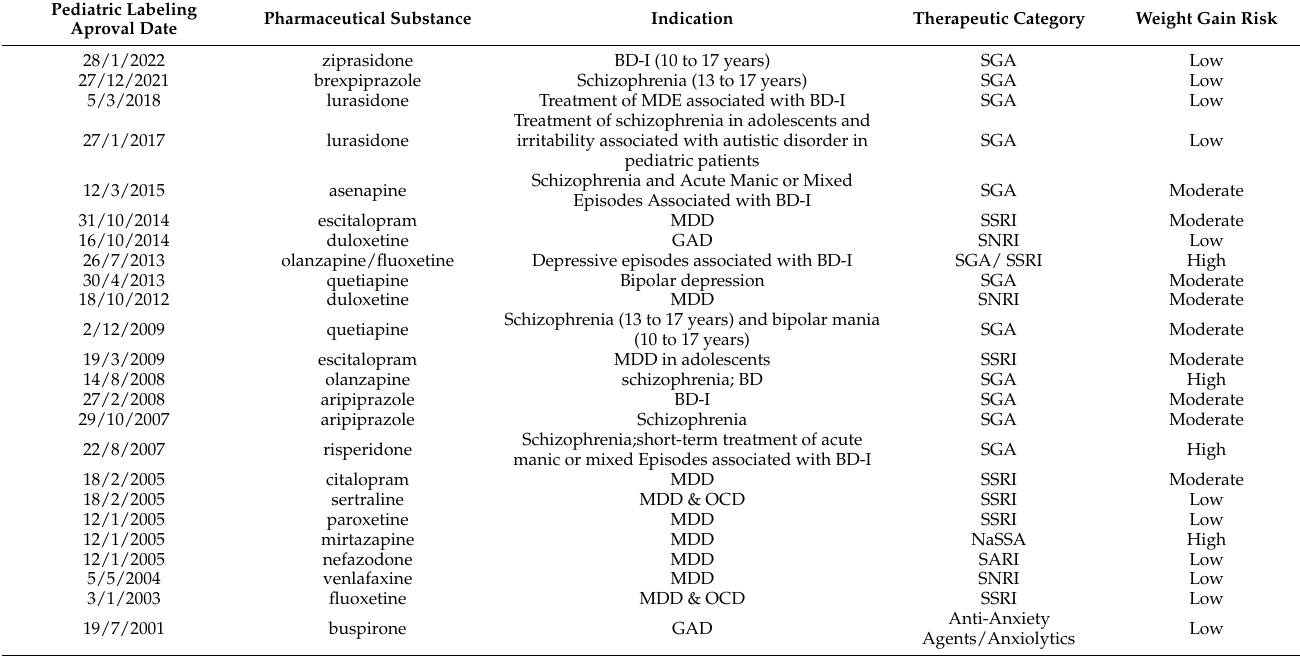
Table 3. Approved psychiatric medication for minors and weight gain